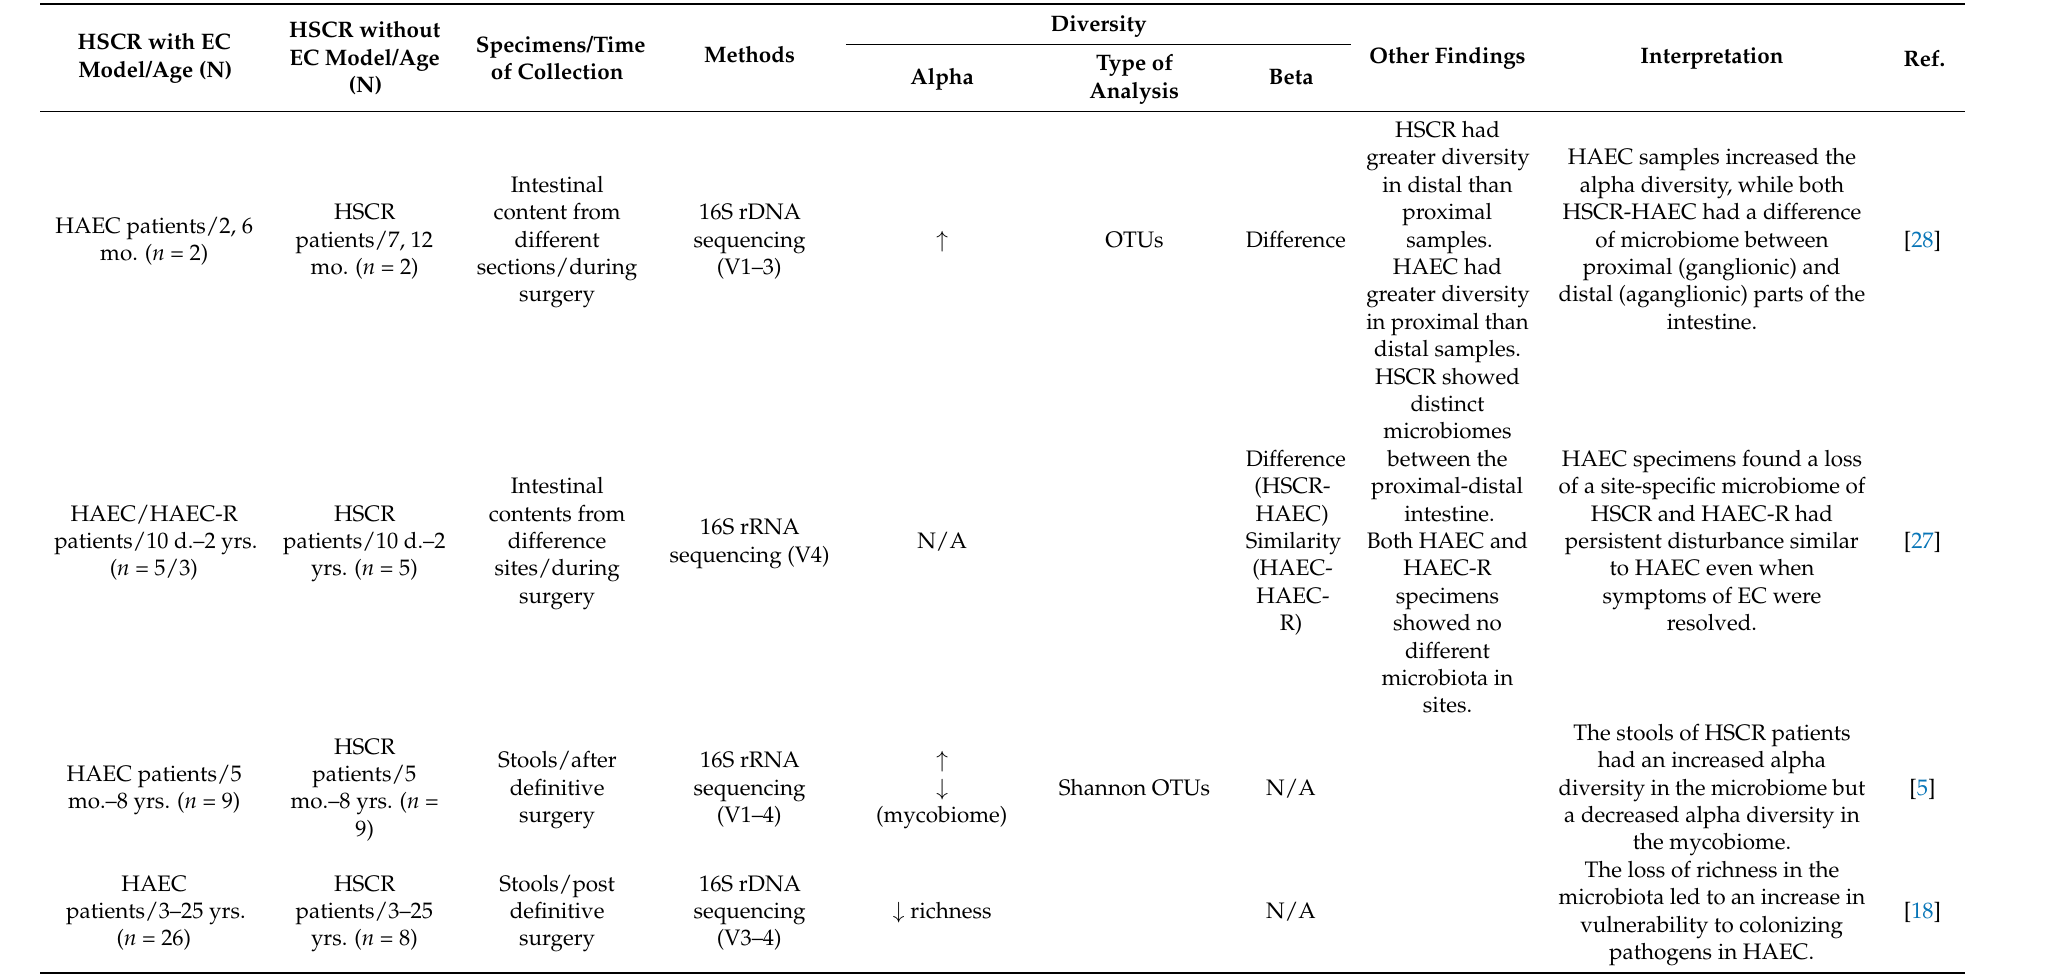
Table 3. The diversity in gut microbiota in Hirschsprung disease with and without enterocolitis: evidence from animal to clinical